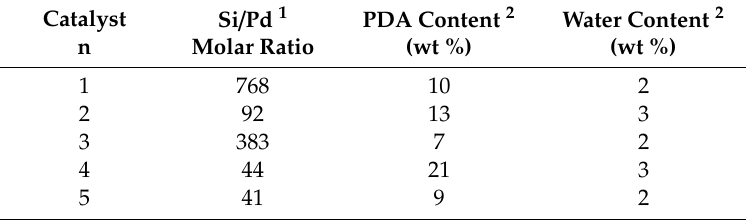
Table 1. Compositional data of the Pd NPs-UVM-7 / PDA- n catalyst Catalyst Si / Pd 1 PDA Content n Molar Ratio